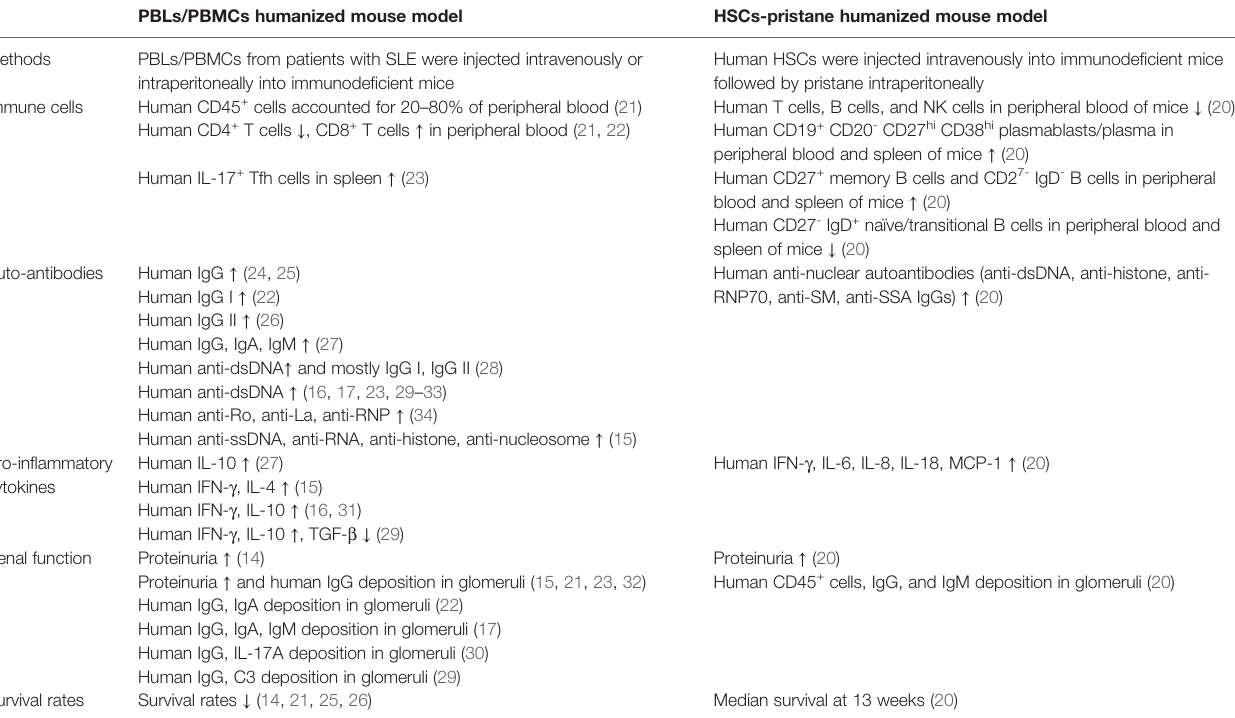
TABLE 1 | The differences between two kinds of humanized SLE mice. PBLs/PBMCs humanized mouse model HSCs-pristane humanized mouse model